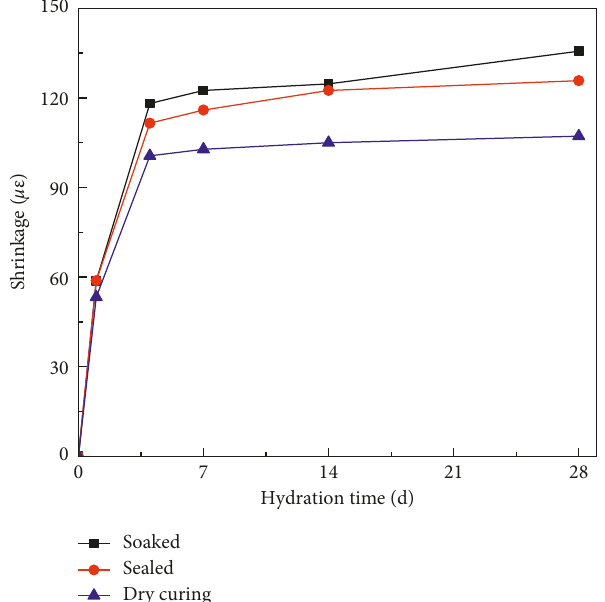
Figure 4: The chemical shrinkage of UHPFRC in different curing